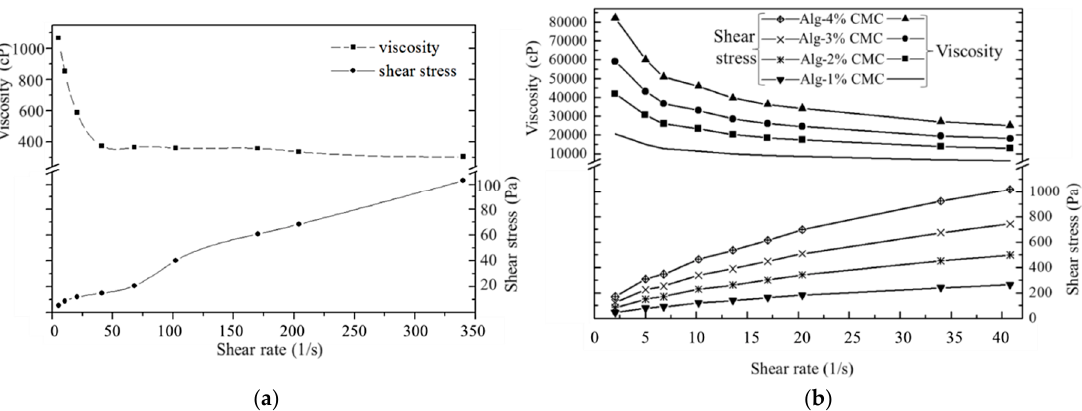
Figure 8. Rheological properties of ( a ) Alginate and ( b ) Alginate-CMC.